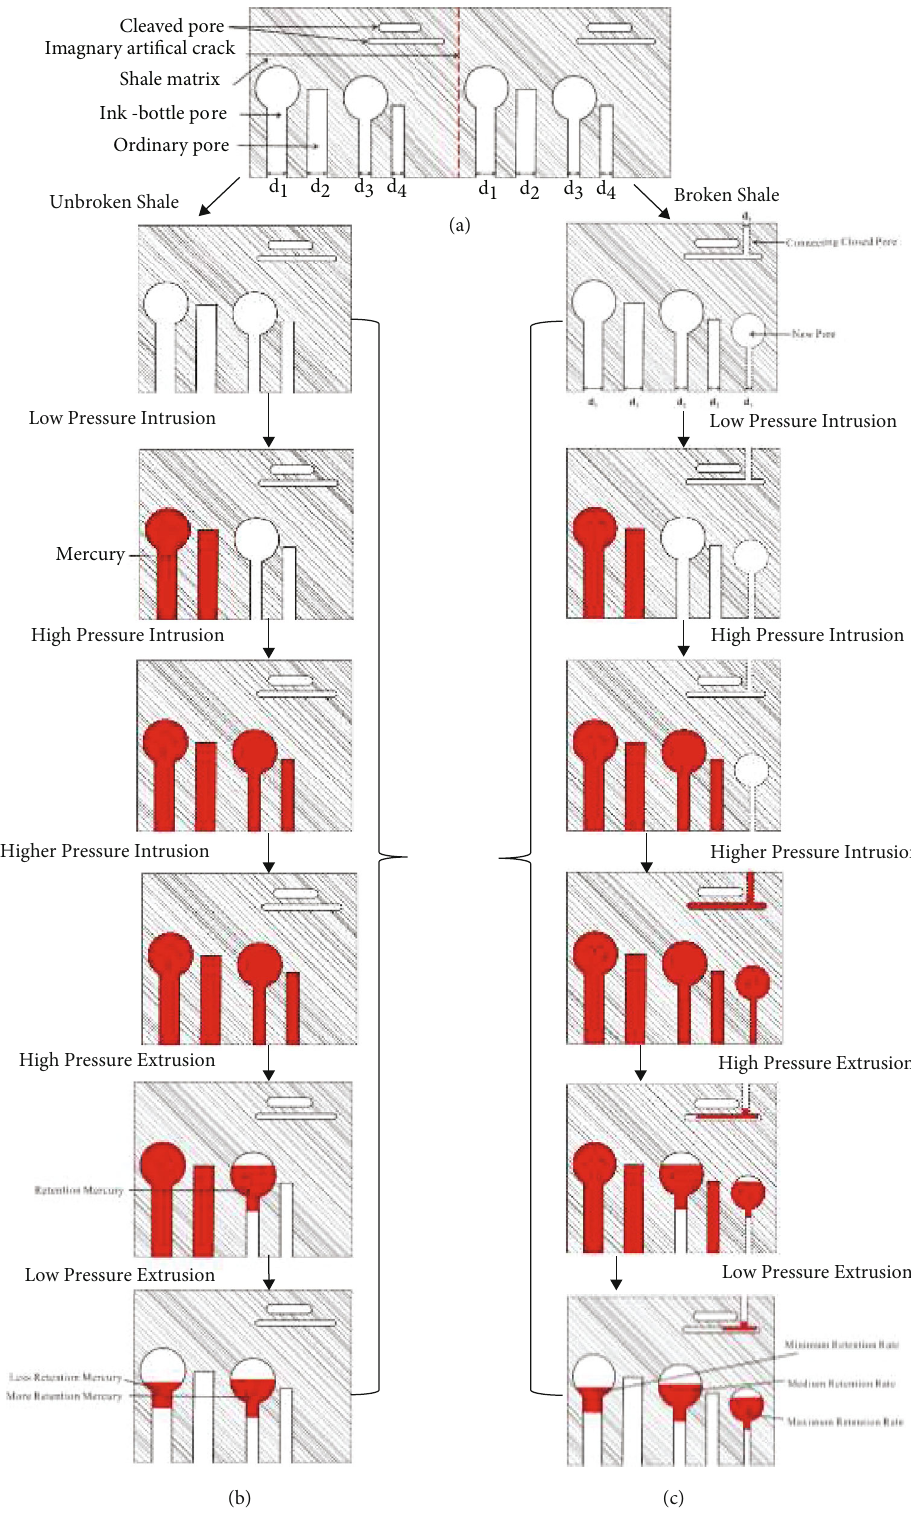
Figure 12: Schematic of mercury intrusion and extrusion in shale with di ff erent particle sizes: (a) shale sample with two identical parts; (b) shale sample with relatively large particle size before sample crushing process; (c) shale sample with relatively small particle size after sample crushing